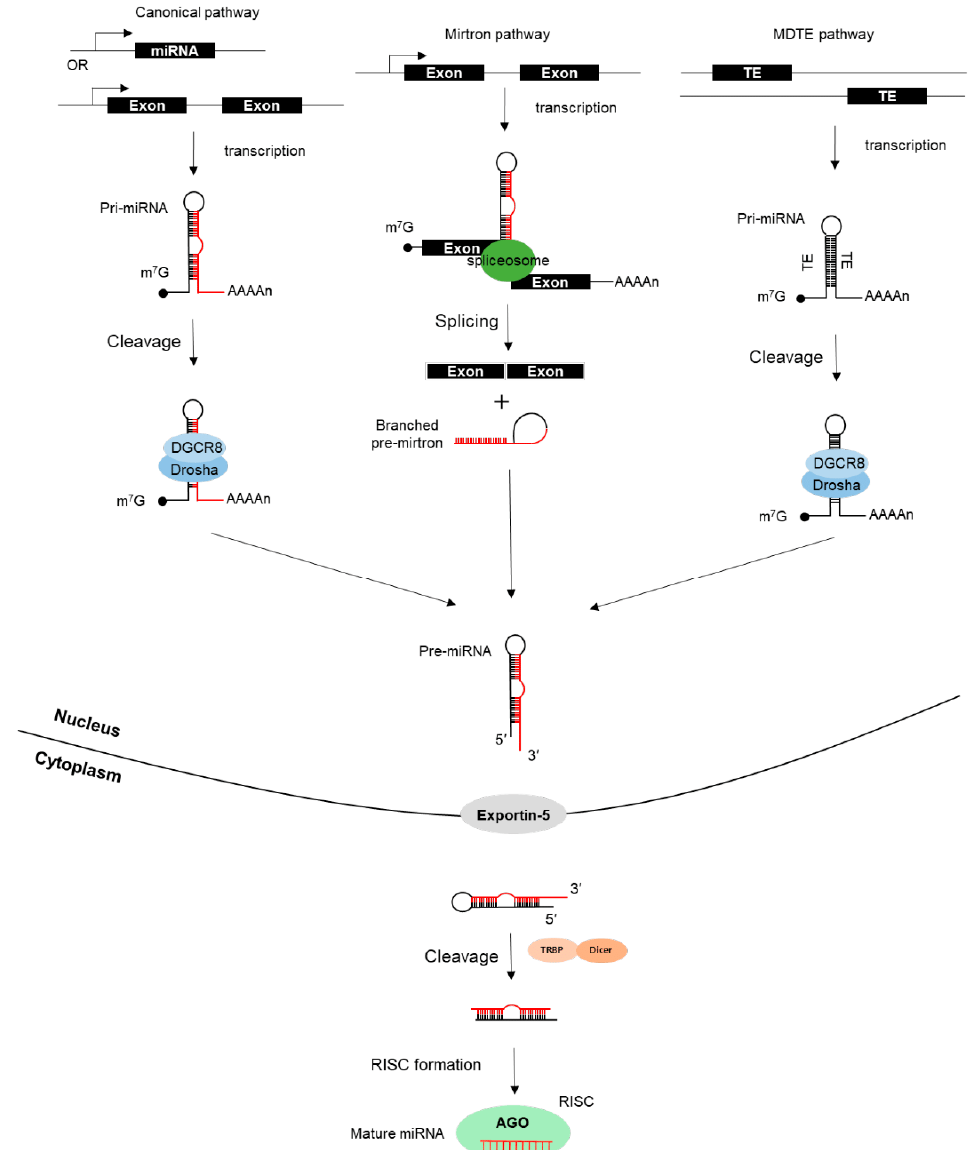
Figure 2. The schematic diagram of miRNA biogenesis via three independent pathways. TE, trans- posable element; m 7 G, 7-methylguanosine; DGCR8, DiGeorge syndrome critical region 8; TRBP, transactivation response element RNA-binding protein; RISC, RNA-Induced Silencing Complex; AGO, Argonaute.